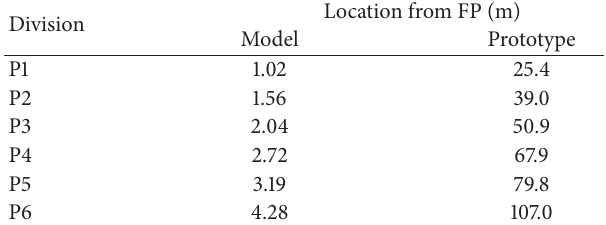
Figure 3: Final design of trimaran model. Table 1: Division location of